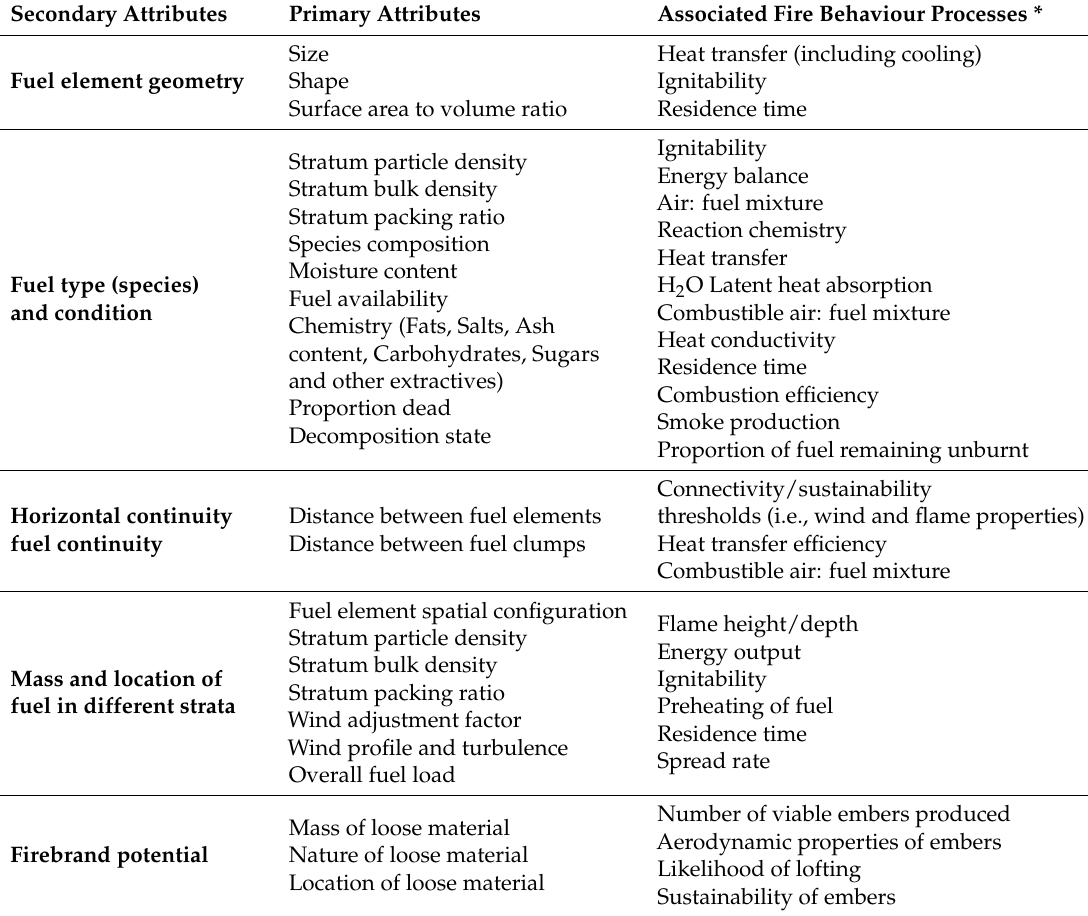
Table 2. Some commonly measured fuel attributes that are assessed at a site level (secondary attributes), the associated (primary) attributes of these that affect fire behaviour, and the fundamental fire behaviour processes they influence [16,34,50,77]. Processes may be associated with more than one primary